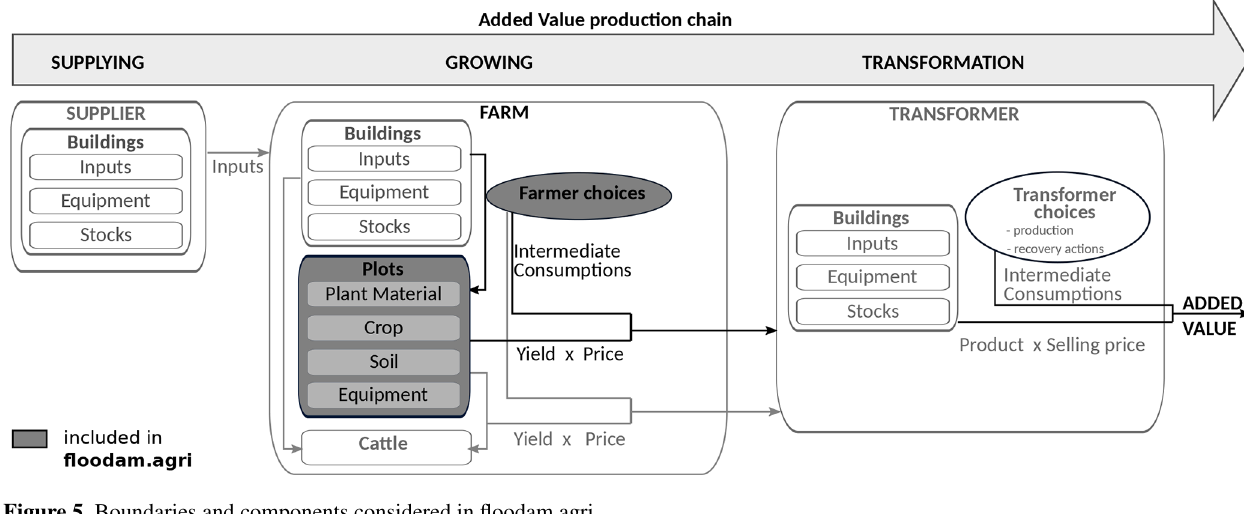
Figure 5. Boundaries and components considered in floodam.agri.